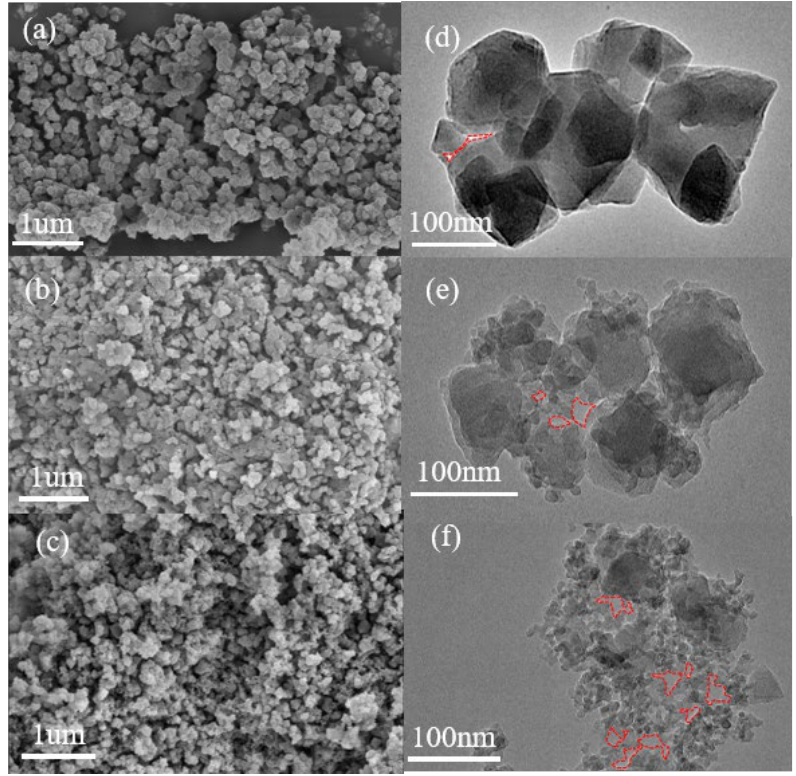
Figure 3. ( a,d ) SEM and TEM images of sample A-0. ( b,e ) SEM and TEM images of sample A-2. ( c,f ) SEM and TEM images of sample A-4. The red dashed area in the TEM image represents the mesoporous structure formed by crystal nanofusion.